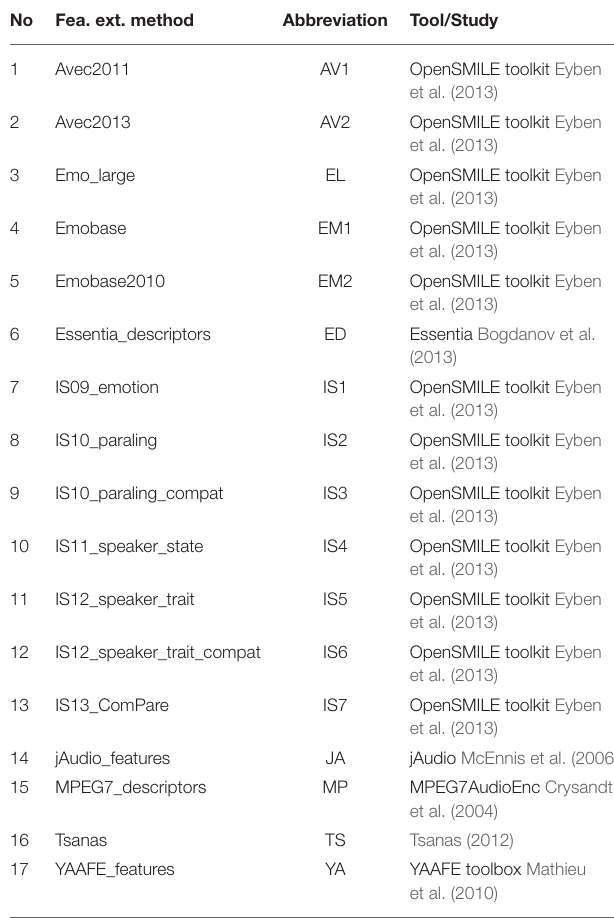
TABLE 1 | Features extraction methods and statistical analysis of the features. No Fea. ext.